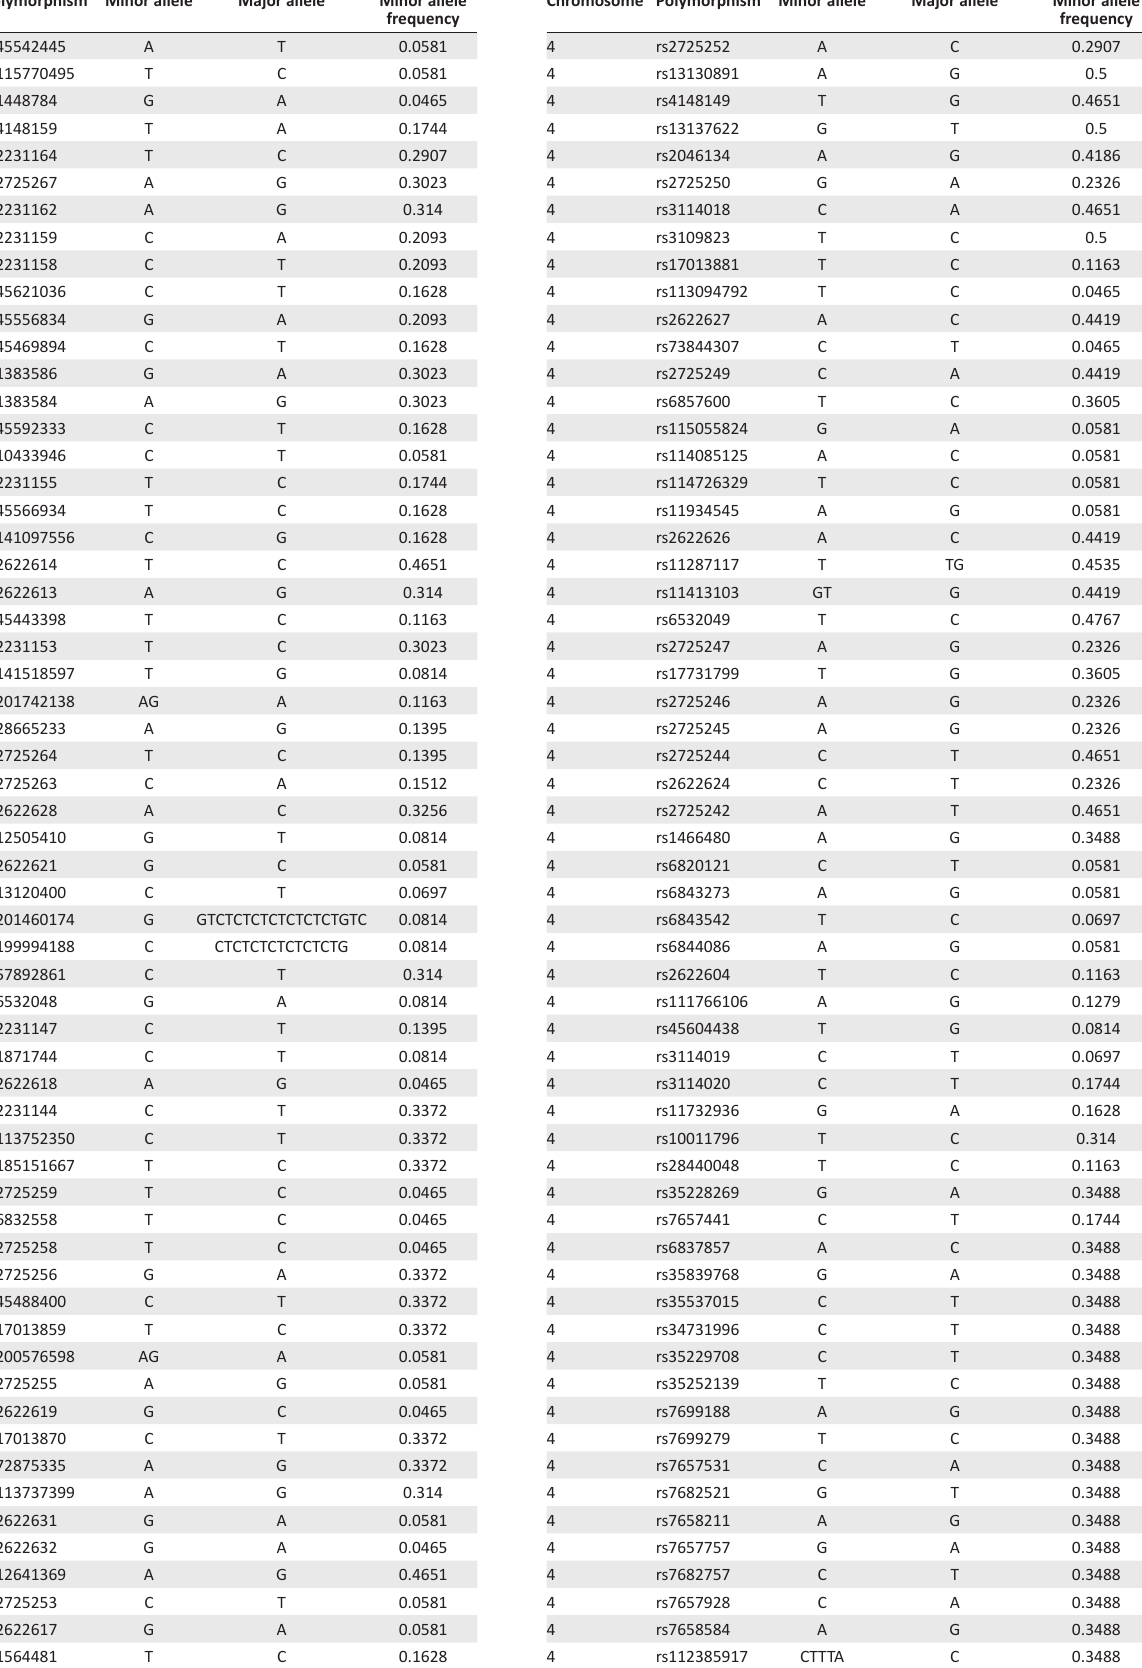
Table 1-A1 (Continues...): Minor allele frequencies for 1846 polymorphisms in 43 black South Africans. Chromosome Polymorphism Minor allele